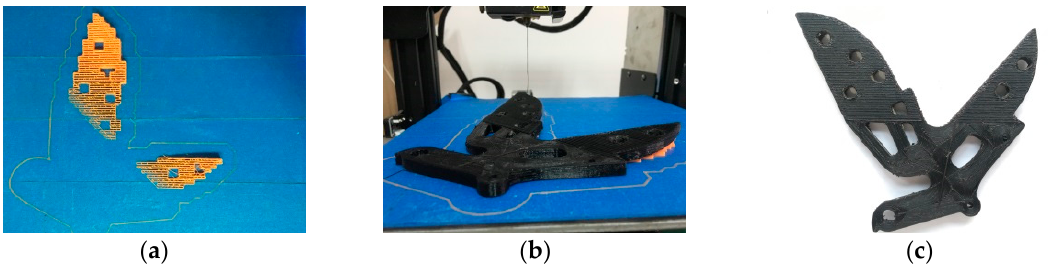
Figure 5. Printing of model with support structures. ( a ) Support structures with pure PLA. ( b ) Printing of bracket of bicycle rear wheel. ( c ) Product with PFRTPCs.